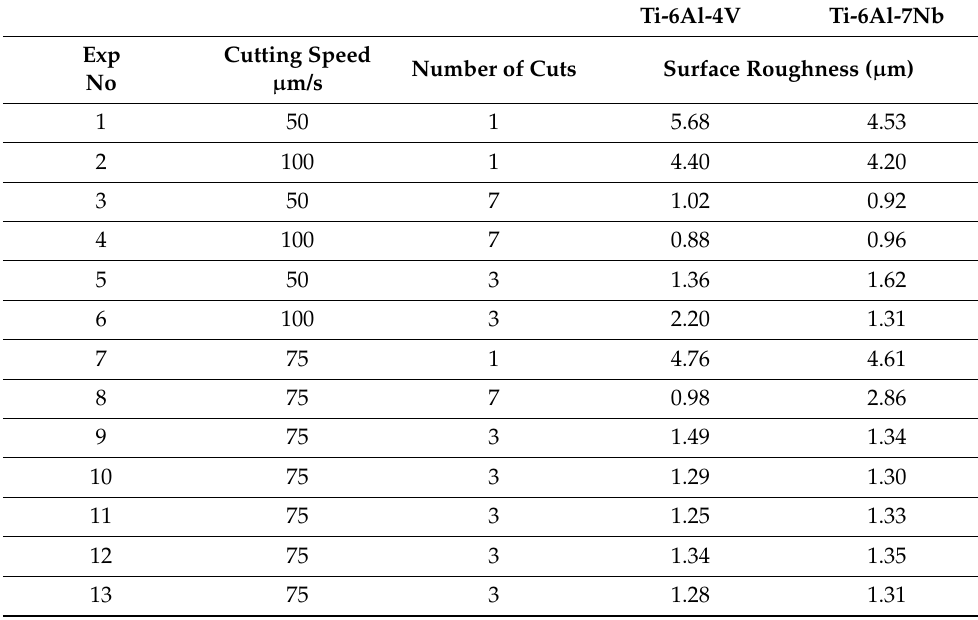
Table 3. Experimental plan and related readings.